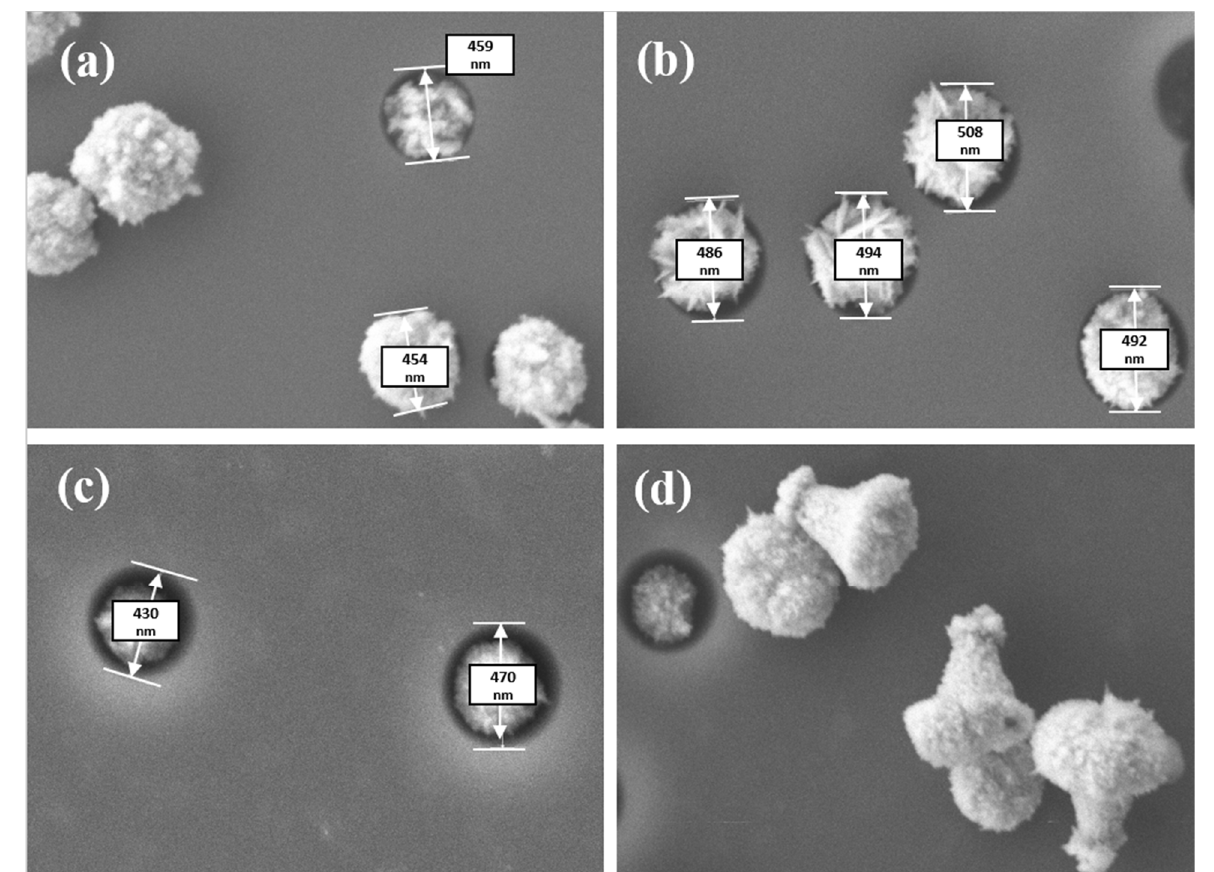
Figure 1. SEM images of pore-filling after 15 min CD ( a ), 20 min CD ( b ), and 25 min CD ( c ), and obtained nanostructures formed on the surface ( d ). The pore diameter varied from 400 to 500 nm.